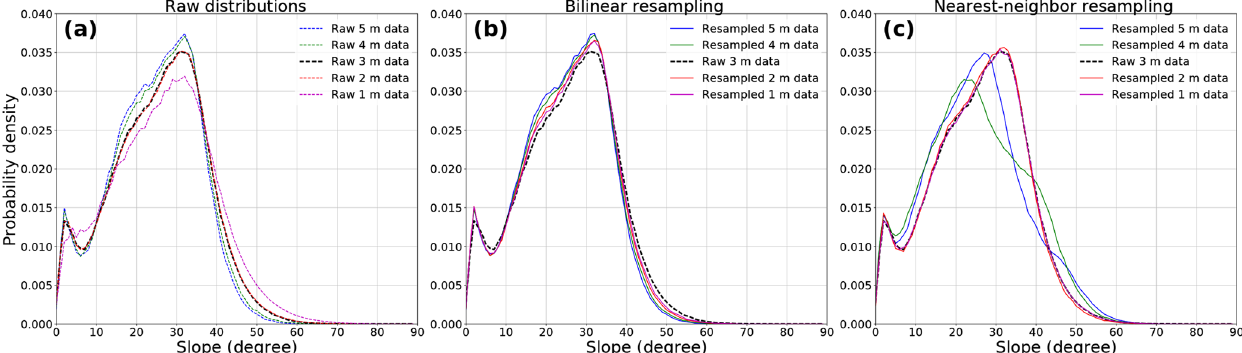
Figure 14. (a) Divergence of higher and lower grid-resolution slope distributions from that at the optimal resolution for the Pozo catchment (see Fig. 9). Except for the 1m histogram, the differences between resolutions are small. Right panels show slope distributions taken from 1, 2, 4, and 5m data resampled to 3m resolution using (b) bilinear resampling and (c) nearest-neighbor resampling. The resampled data distributions do not converge on the reference 3m distribution, except for the 1m data resampled with a nearest-neighbor